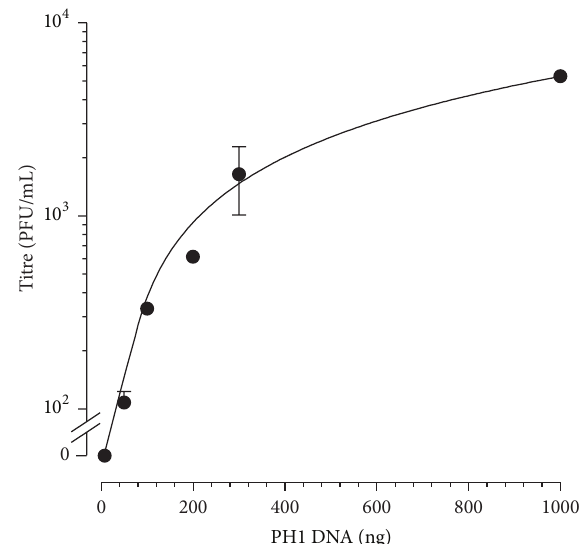
Figure 7: Transfection of Har. hispanica cells with PH1 DNA. Vary- ing amounts of nonproteinase K-treated PH1 DNA were introduced into cells of Har. hispanica using the PEG method [64]. Cells were thenscreenedforinfectivecentresbyplaqueassay.Datashownisthe average of three independent experiments, performed in duplicate. Error bars represent one standard deviation of the mean. If protease- treated DNA was used, no transfectant plaques were